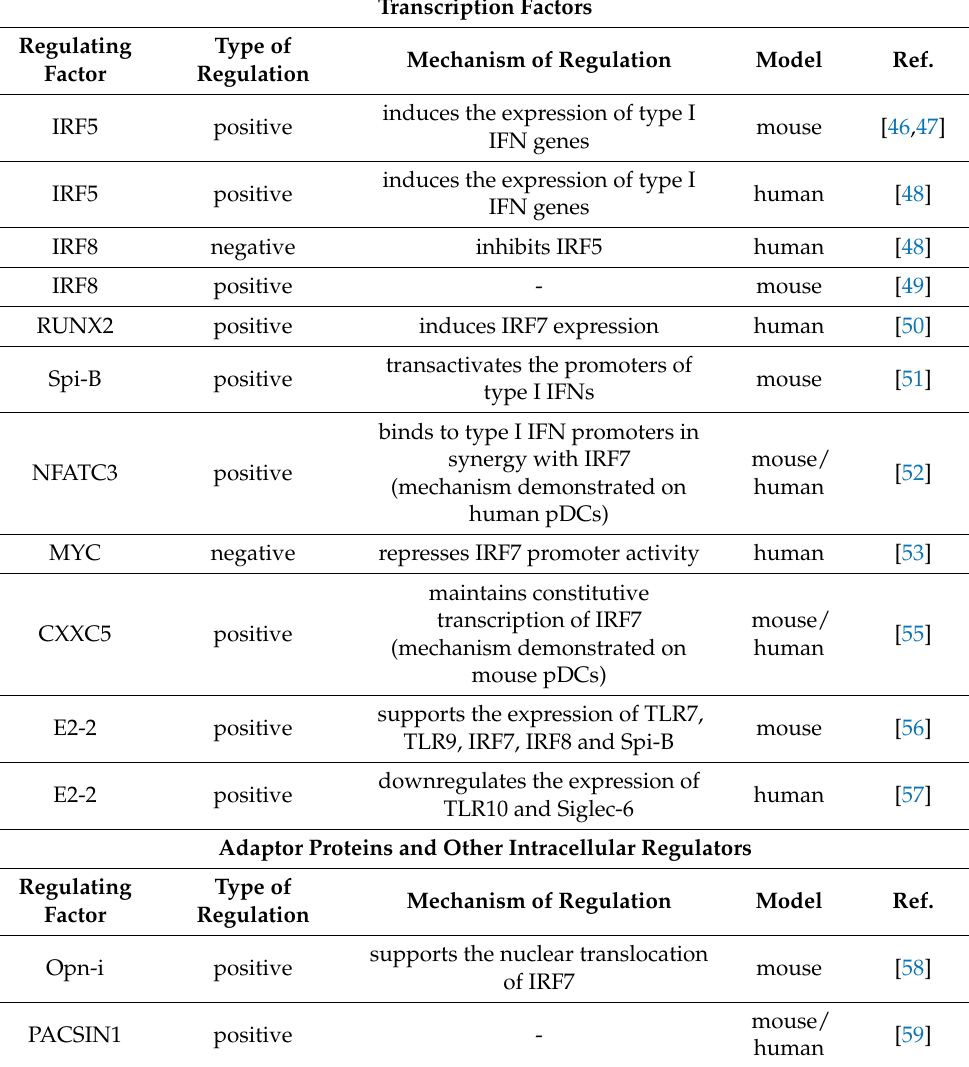
Table 1. Regulation of type I IFN production at the transcriptional and posttranscriptional